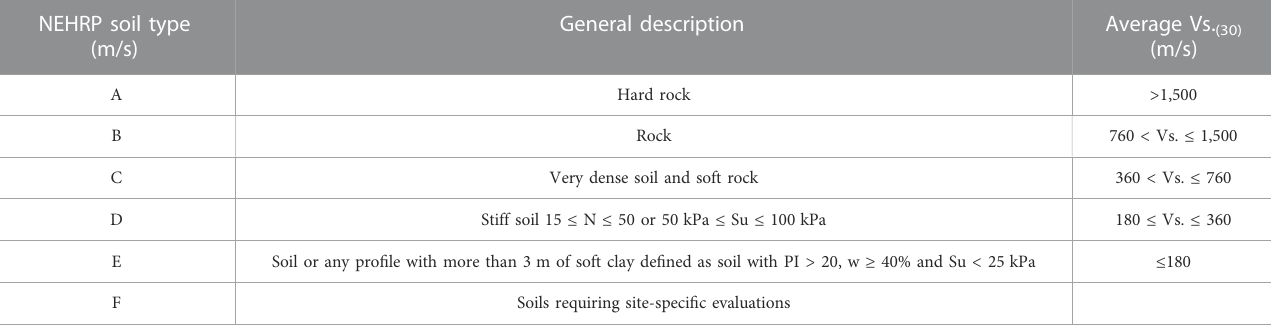
TABLE 1 The NEHRP soil pro fi le type classi fi cation for seismic ampli fi cation (BSSC, 2003). NEHRP soil type